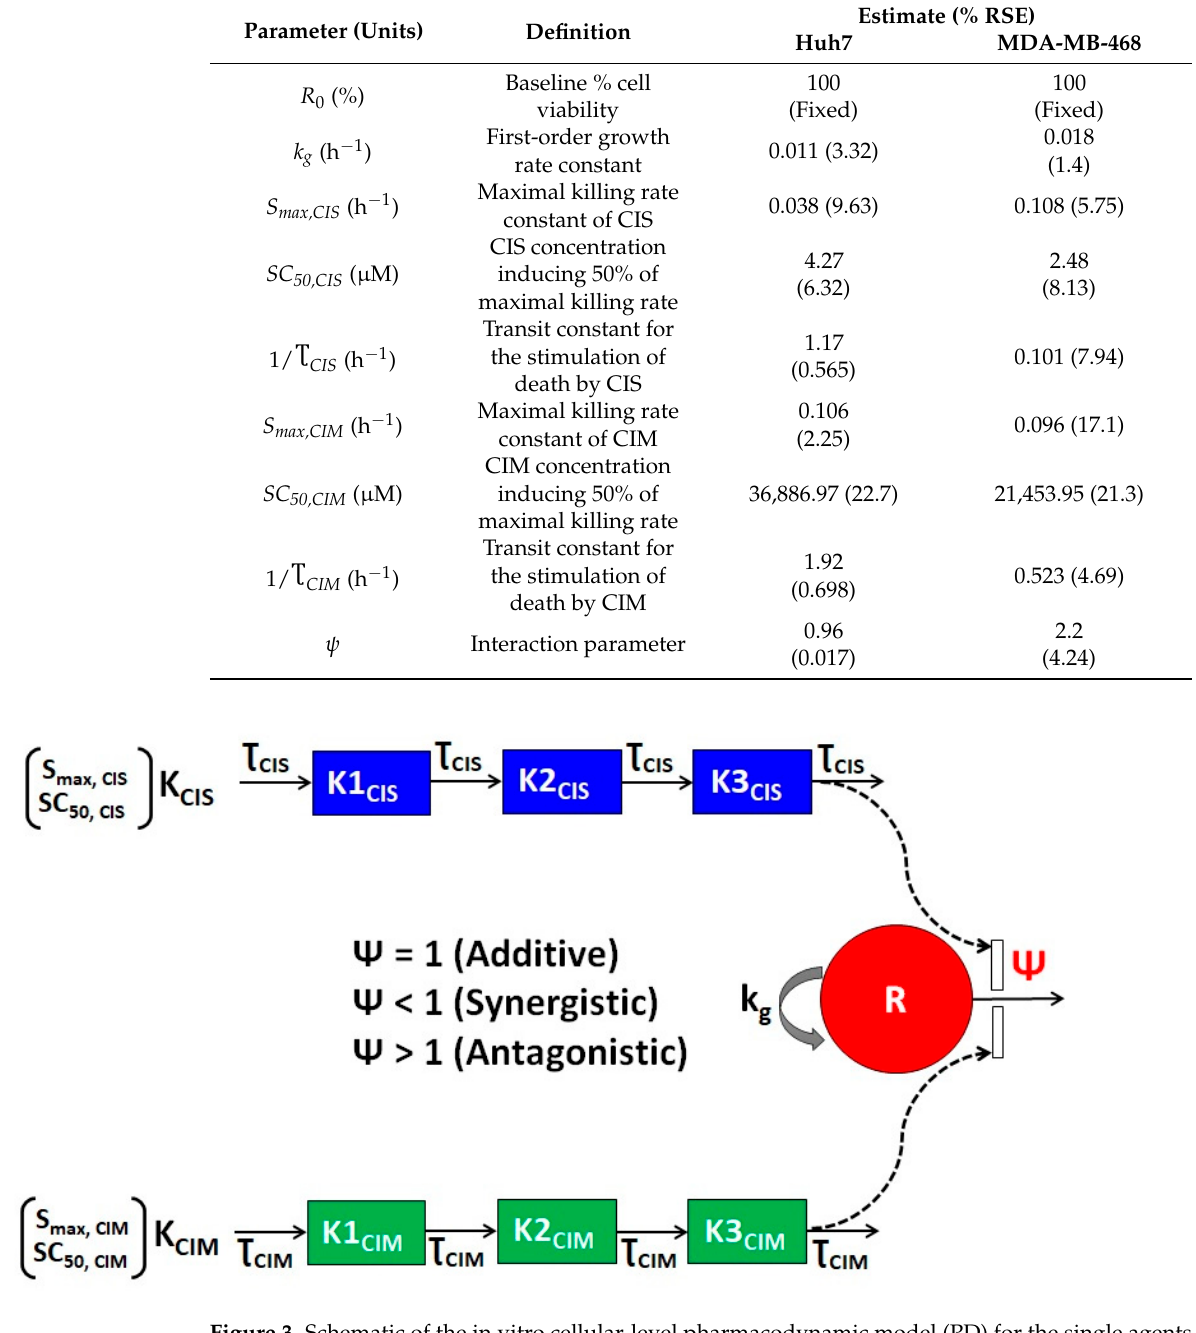
Figure 3. Schematic of the in vitro cellular-level pharmacodynamic model (PD) for the single agents CIS and CIM and their combination effects on human cancer cell lines, Huh7 and MDA-MB-468. All the model parameters and their definitions are listed in Table 2. Solid lines with arrows denote turnover of the indicated response. The red circle represents cell viability while the blue or green boxes represent transit compartments to describe the delay in the effects of CIS or CIM, respectively. The open solid rectangles represent the stimulation of death induced by CIS, CIM as single agents or by their combination as indicated by dashed black arrows. The interactions of CIS and CIM on the stimulation of death of cancer cells is captured by ψ with ψ = 1, ψ < 1, or ψ > 1 indicating additive, synergistic, or antagonistic interactions, respectively. Table 2. Parameter estimates for the in vitro cellular-level pharmacodynamic model (PD) for the single and combinatorial effects of CIS and CIM on Huh7 and MDA-MB-468. % RSE = % relative standard error in the model parameters.